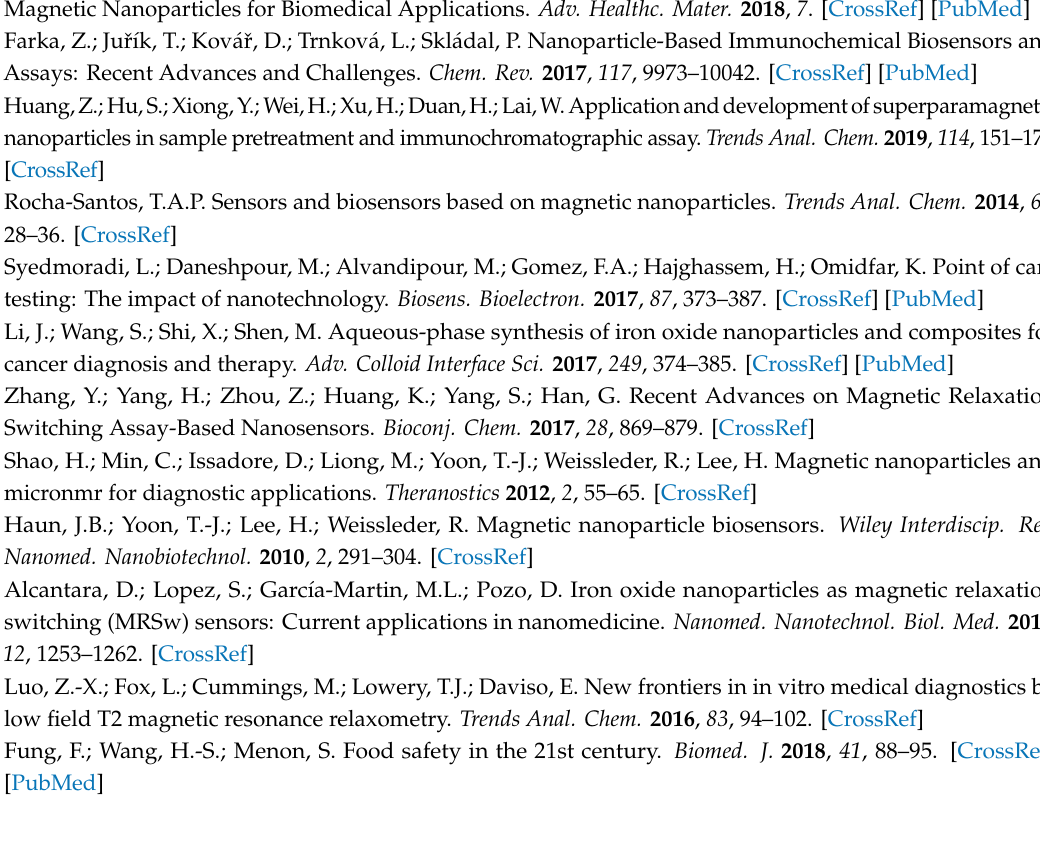
Figure S8. Hydrodynamic diameter and polydispersity of “small”, “medium”, and “large” Fe@C-NH 2 / Protein / Str; Figure S9. Zeta potential of “small”, “medium”, and “large” Fe@C-NH 2 / Protein / Str; Figure S10. Migration of Fe@C-NH 2 / protein / Str and Fe@C-NH 2 / protein / G in 0.5% agarose gel (Tris-HCl pH 8, 75V); Figure S11. Principle of NMR-assay of Bi-BSA on nitrocellulose membrane (top). Sample holder with test strip (bottom); Figure